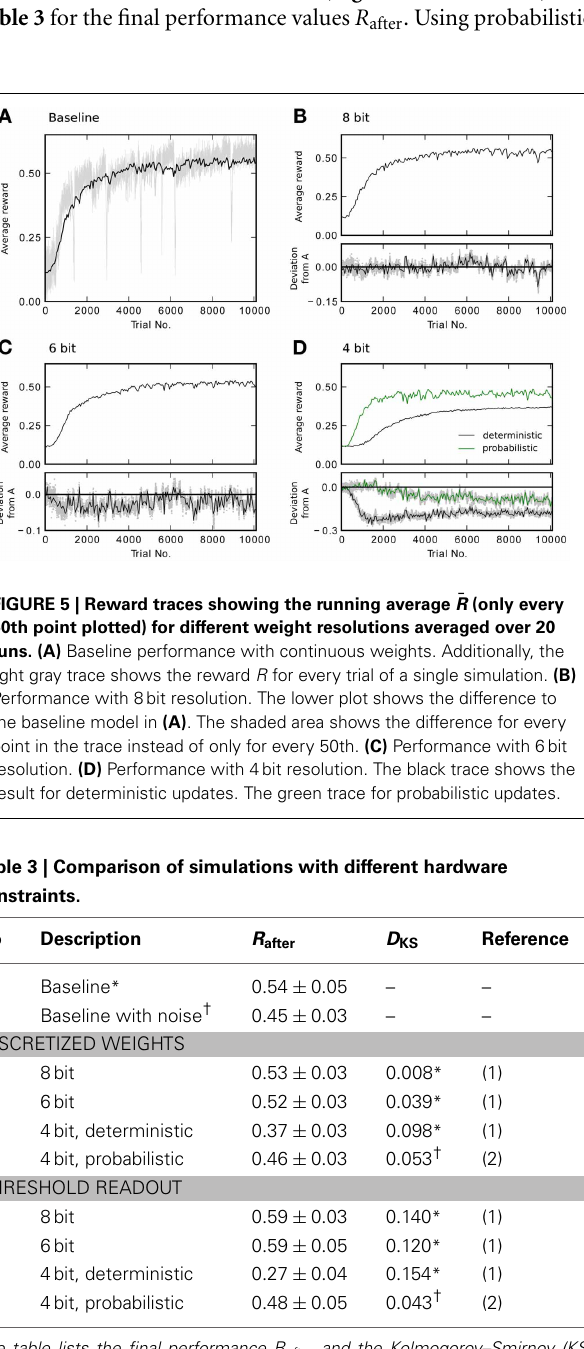
Table 3 for the final performance values R after . Using probabilistic